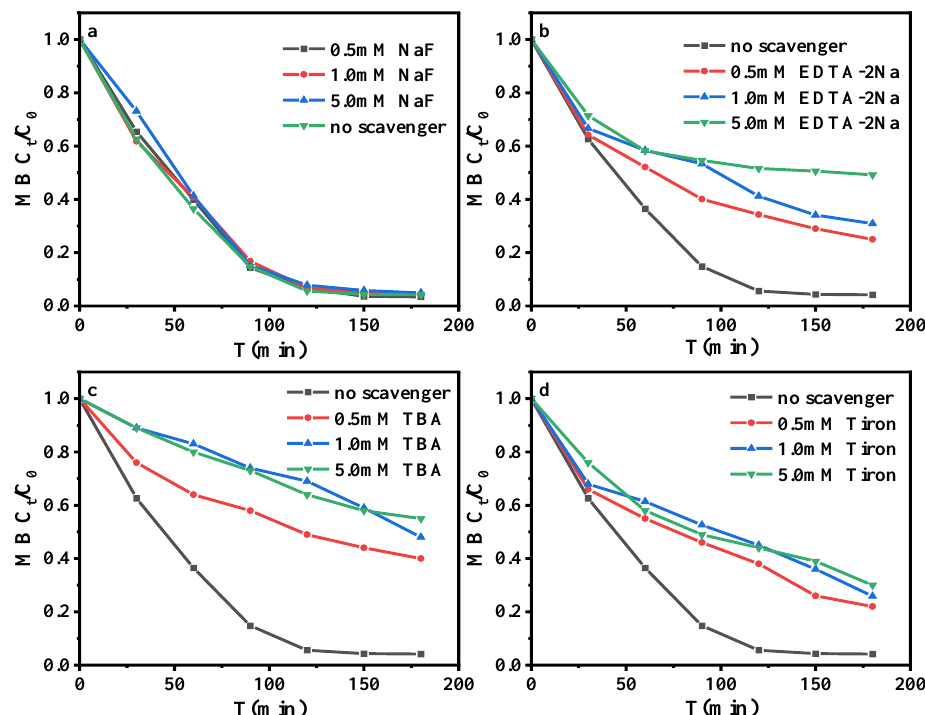
Figure 3. Effect of ( a ) NaF; ( b ) EDTA-2Na; ( c ) TBA; and ( d ) Tiron quenching agent on MB removal efficiency. Reaction conditions: light intensity = 80 W; [MB] = 100 mg/L; and pH = 8.2; [CaWO 4 ] = 1.0 g/L.